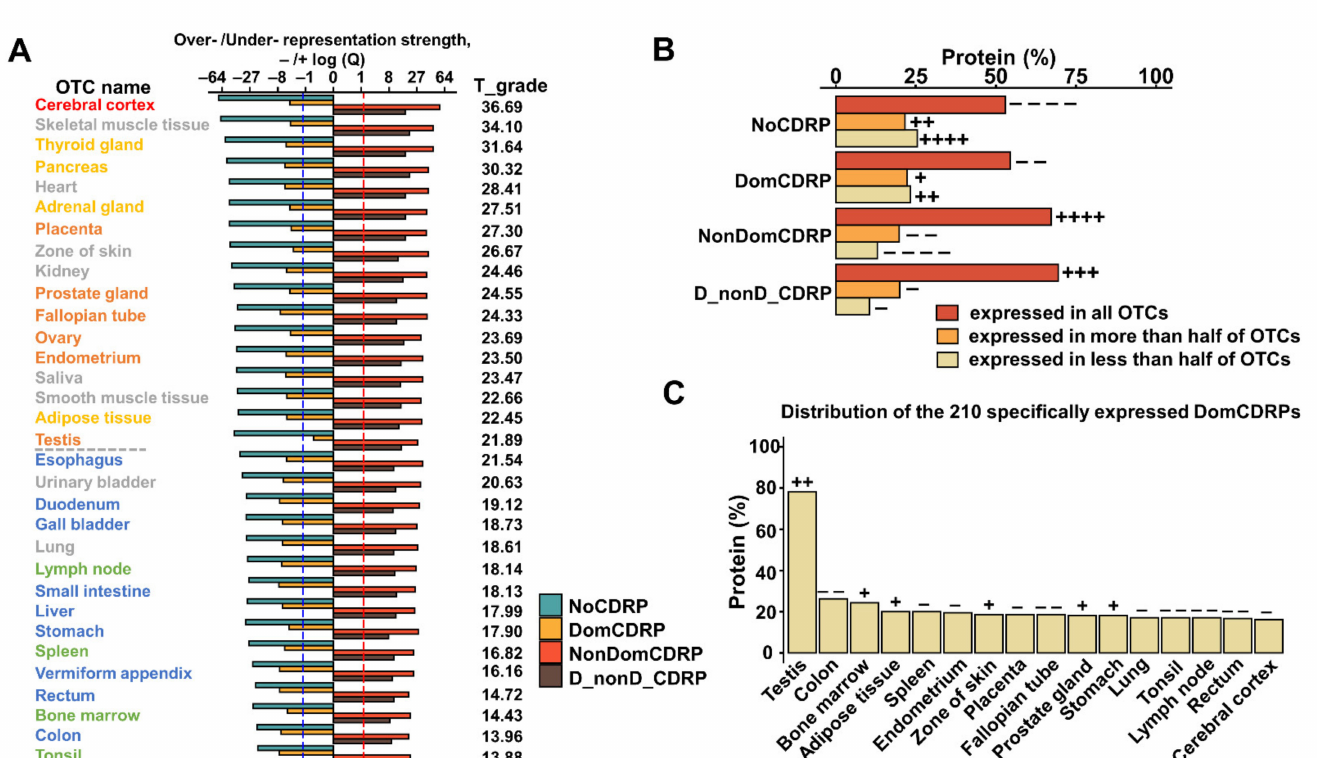
Figure 4. The expression patterns of four types of proteins in 32 organ, tissue or cell types (OTCs). ( A ) Over- or under- representation strengths of each protein category in 32 OTCs. Over- and under- representation are represented by -log(Q) or log(Q), respectively (see Methods for details). The red/blue dashed line represents the –/+log(Q) value corresponding to significant over- or under-representation. T_grade represents the strength for its consistence with the general over- or underrepresentation trends of most OTCs. Red OTC name belongs to the “nervous system”; gold OTC names belong to the “endocrine System”; orange OTC names belong to the “reproductive system”; blue OTC names belong to the “digestive system”; green OTC names belong to the “immune system” and grey OTC names belong to other systems. The grey dashed line separates two groups of OTCs with stronger/weaker over-/under-representation strengths. ( B ) Percentage of proteins in three groups with different OTC-specific grades. ( C ) Distribution of the 210 specifically expressed DomCDRPs. Selected OTCs are the OTCs with top 16 DomCDRPs’ expression percentages. Fisher’s exact test was used to calculate the over- or under-representation strength, and the P values were corrected using the Benjamini–Hochberg method. The results are Q values. ++/ − − represents Q ≤ 0.05, +++ represents Q ≤ 1 × 10 –10 ; ++++/ − − − − represents Q ≤ 1 × 10 –50